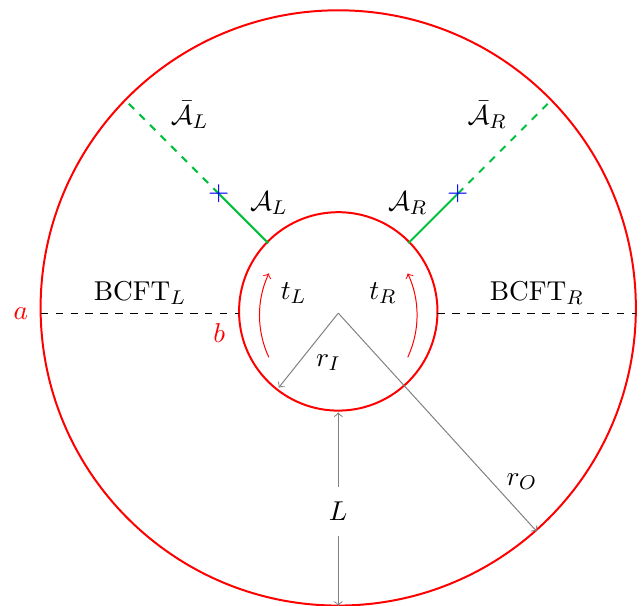
Figure 5 . The two-dimensional CFT on a strip at a finite temperature: the two BCFTs L and R are in the TFD state. Time evolution is rotation with respect to the origin, and the red circles are the time evolution of the two boundaries. The boundary conditions are specified as a and b . The black dashed line is the t = 0 slice, and the choice of time evolution is indicated. We are interested in the entanglement entropy of the subsystem A = A corresponding to the solid green line L ∪ A R segments connecting the inner boundary and the blue